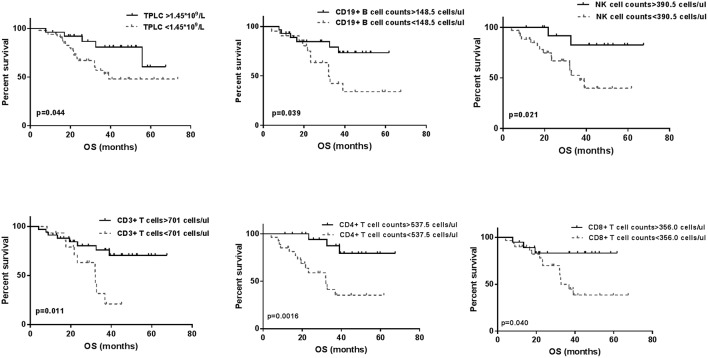
The Kaplan-Meier overall survival (OS) curves for baseline total peripheral lymphocyte count (TPLC) and different circulating lymphocyte populations (CLPs). Within 3 days prior to stereotactic body radiation therapy, significant differences for high level (—) and low level (- - -) of TPLC and all CLP types for OS curves were observed (p < 0.05 for each).